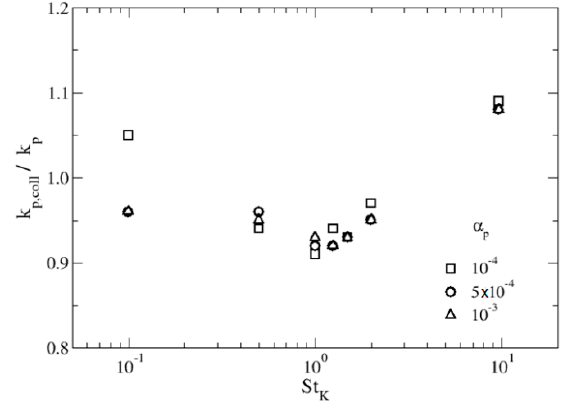
Figure 10. Average of particle kinetic energy of colliding particles over mean particle kinetic energy over all particle locations, k p , coll / k p , as a function of particle Stokes number for the three evaluated average volume fractions.